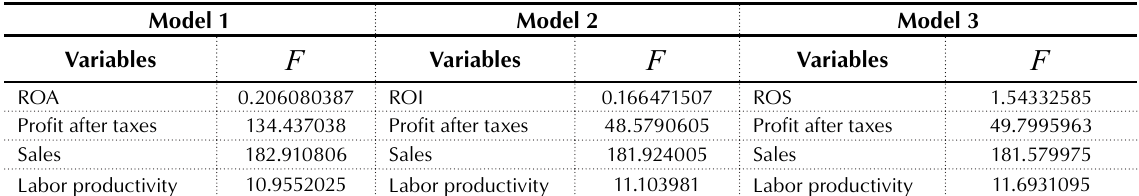
Table 4. Summary results of Fisher test variables of each model